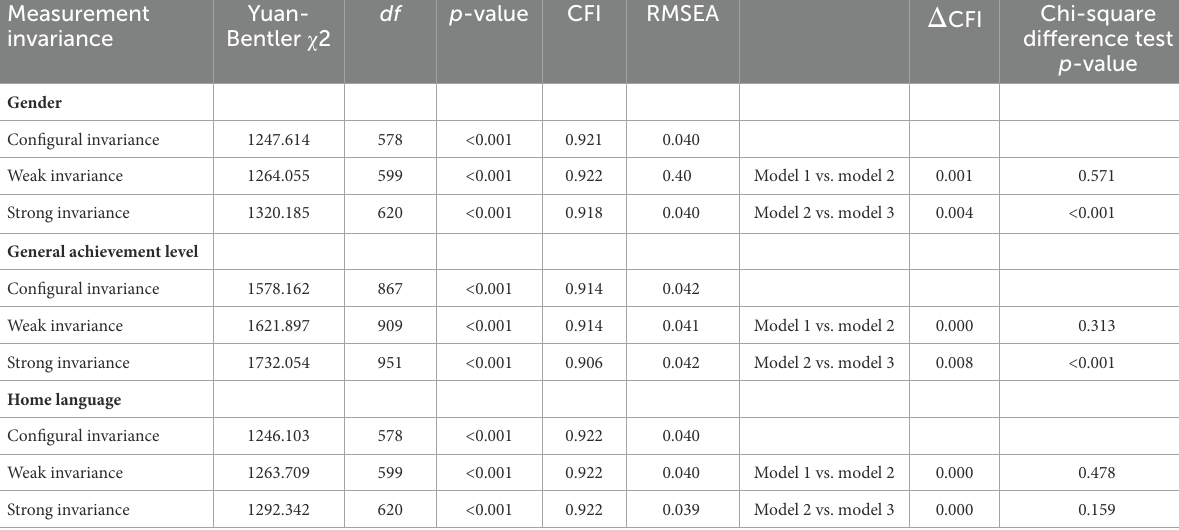
TABLE 2 Measurement invariance testing: Summary of the goodness-of-fit statistics. Measurement